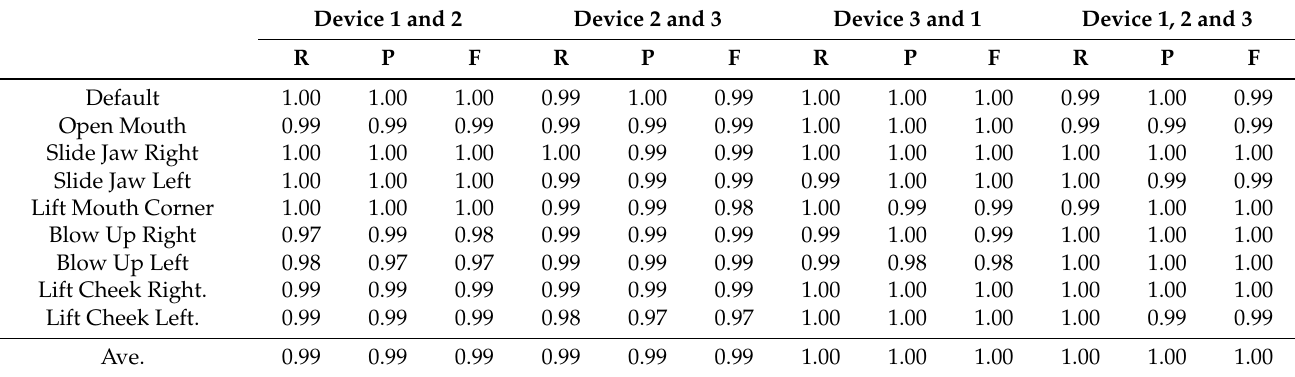
Table A2. The results of multiple device combinations for each gesture in Evaluation 1. Device 1 and